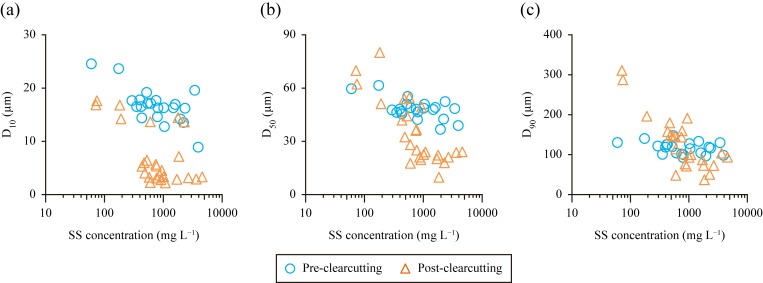
Plots of suspended solid (SS) partitioned by relative particle size D10 (a), D50 (b), and D90 (c) against logarithmic SS concentration in the samples collected over the entire catchment outlet. D10, D50, and D90 represent 10%, 50%, and 90% of the volume-based cumulative particle size distributions. Note that the Y-axis scales differ between (a), (b), and (c).